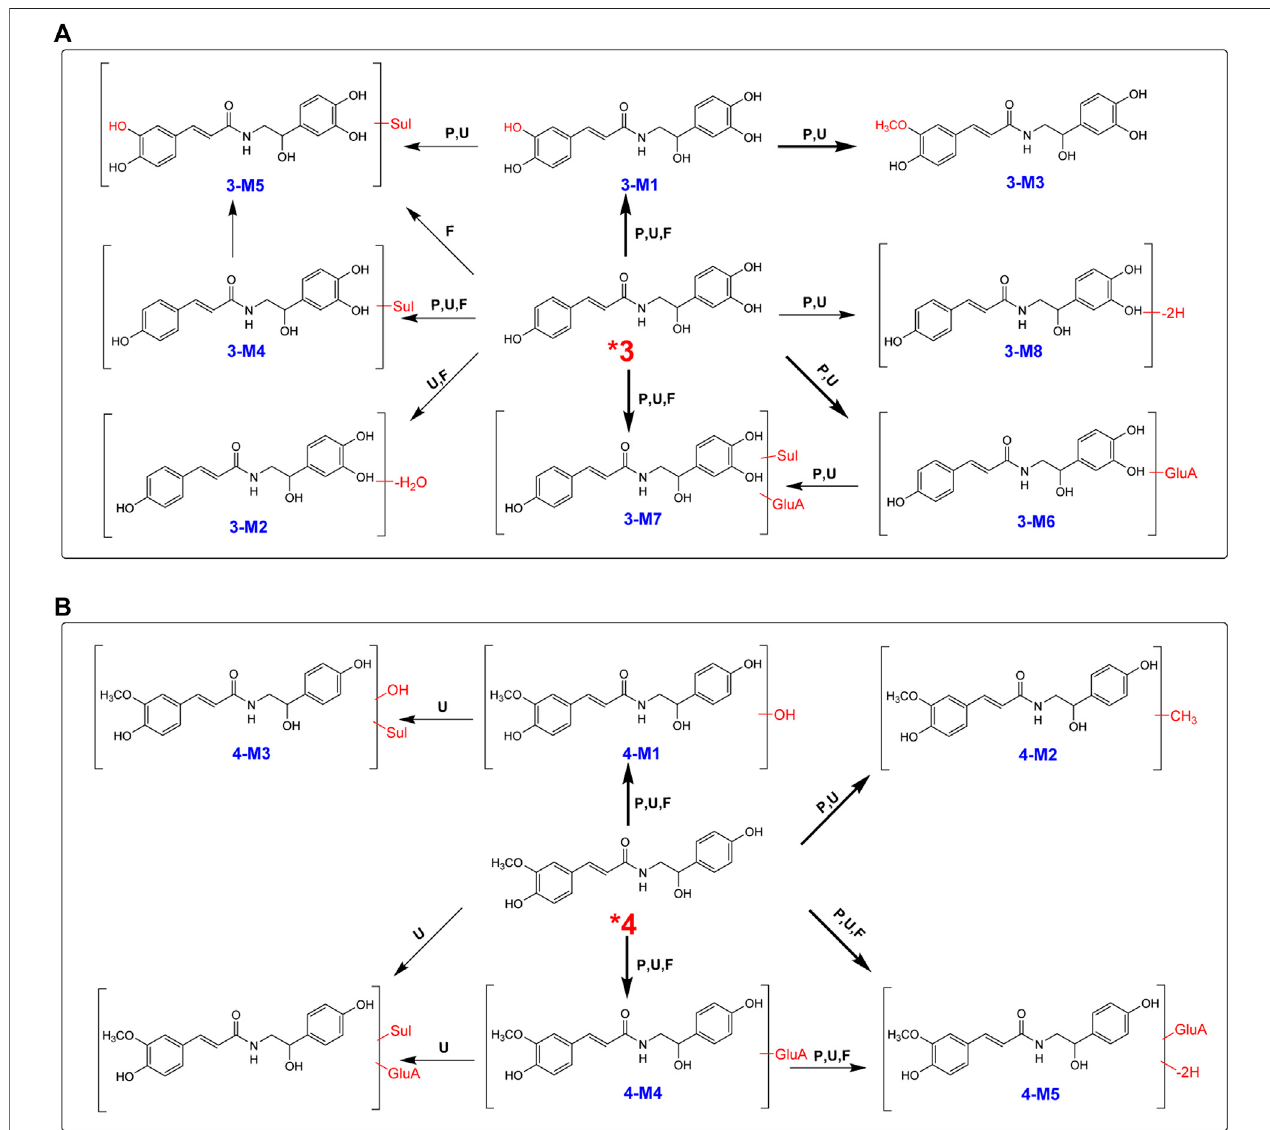
FIGURE 6 | Proposed metabolic pathways for 3 (A) and 4 (B) in rats after oral administration.